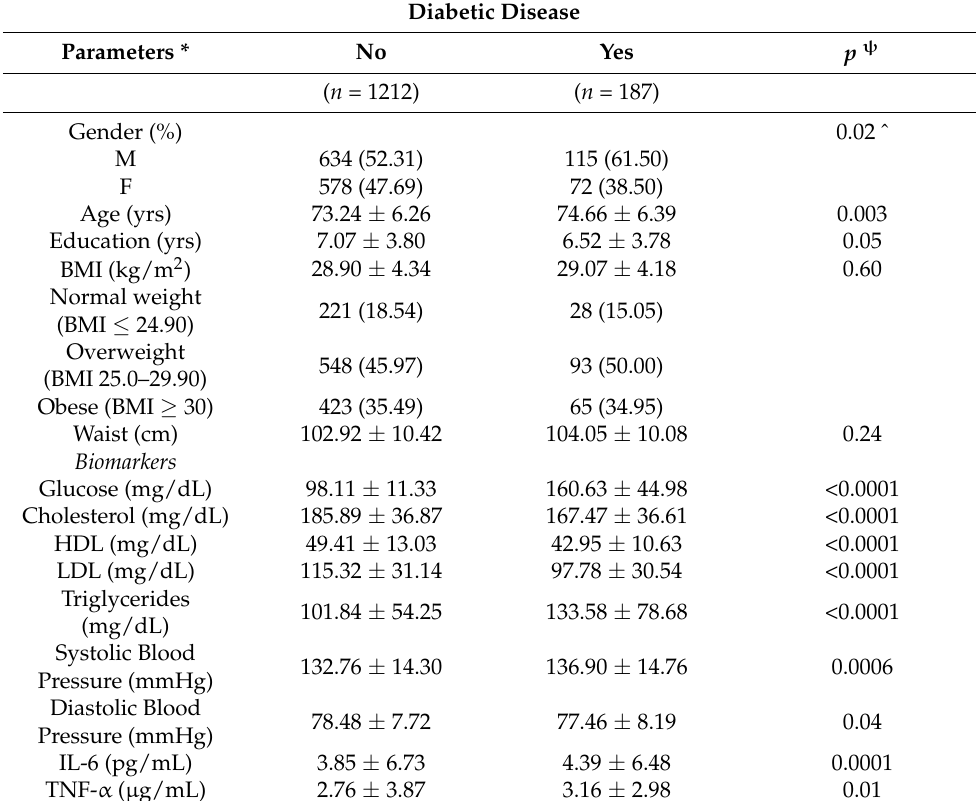
Table 1. Sociodemographic and clinical variables in patients with and without diabetic disease (Yes/No). The Salus in Apulia Study ( n =